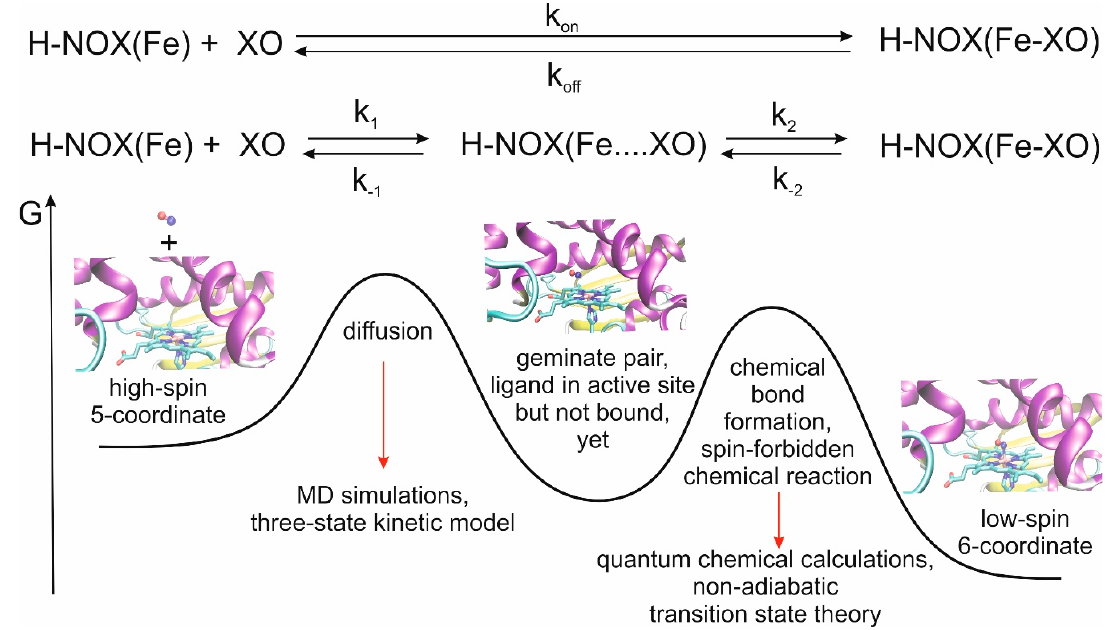
Figure 1. Ligand binding by Heme-Nitric oxide and OXygen (H-NOX) proteins and definition of the relevant rate constants. Experimentally, and usually, k on and k off are determined, while calculations allow us to study the steps individually and obtain the values of k 1 , k − 1 , k 2 and k − 2 . The overall process can be divided into two major events: diffusion of the ligand to the active site and the formation of the bond between the ligand and the Fe(II) ion. Due to the nature of the two events, different methodologies are required for their proper description, and as the spins are inverted on iron in the course of the chemical reaction, a special form of transition state theory is needed for the derivation of the rate constant values [15,22].